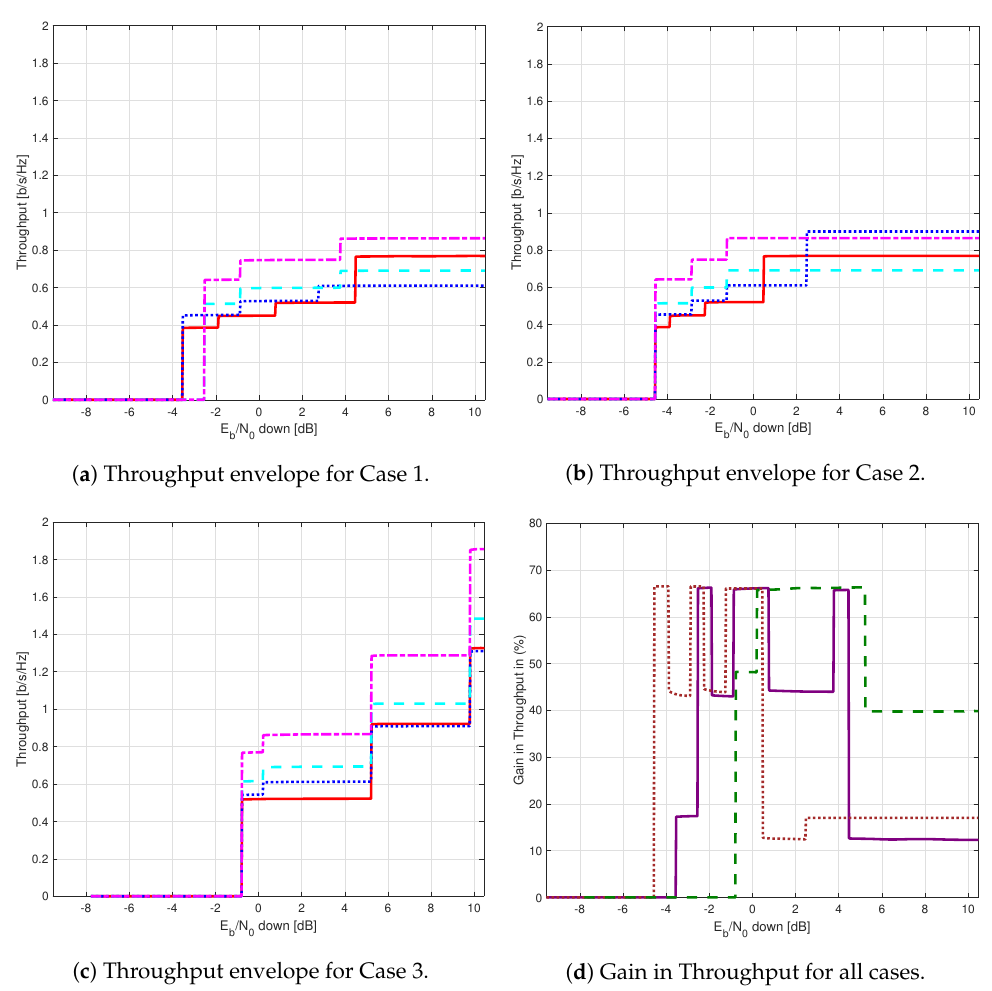
Figure 14. End-to-end throughput envelope (left and upper-right) and gain in the throughput envelope of time-packed versus no-time-packed (lower-right), represented as a function of the E b / N 0 in the access link for Cases 1–3. Overlapping of δ = 0% (solid red line), δ = 15% (dotted blue line), δ = 25% (dashed cyan line), and δ = 40% (dashed-dotted magenta line). Figure 14d shows the gain in throughput of time-packed with respect to no-time-packed; here, Case 1 is represented with a continuous purple line, Case 2 is plotted with a dotted brown line, and Case 3 is shown with a dashed green line. Wind speed: v = 21m/s. Diameter of telescope aperture: W 0 = 10cm. Figure 15 shows the envelope of the throughput for all cases in terms of the over- lapping factor. From these figures, it is possible to observe that for Cases 1 and 3, the larger is the overlapping factor, the larger is the maximum throughput that is feasible when δ = 40%. On the contrary, for Case 2, the maximum throughput is achieved when δ =